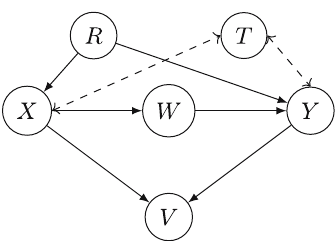
Figure 6: Feature selection playground on a causal diagram with treatment X , outcome Y , and other